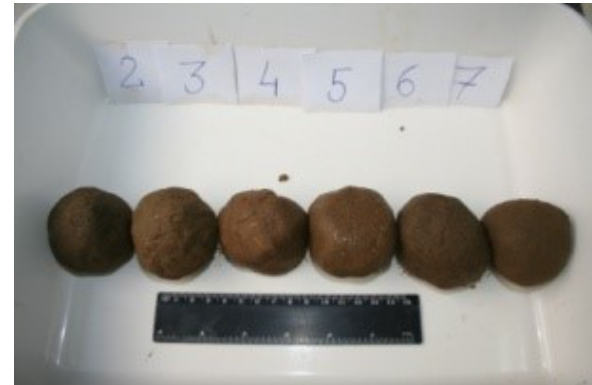
Figure 6: EBM balls.